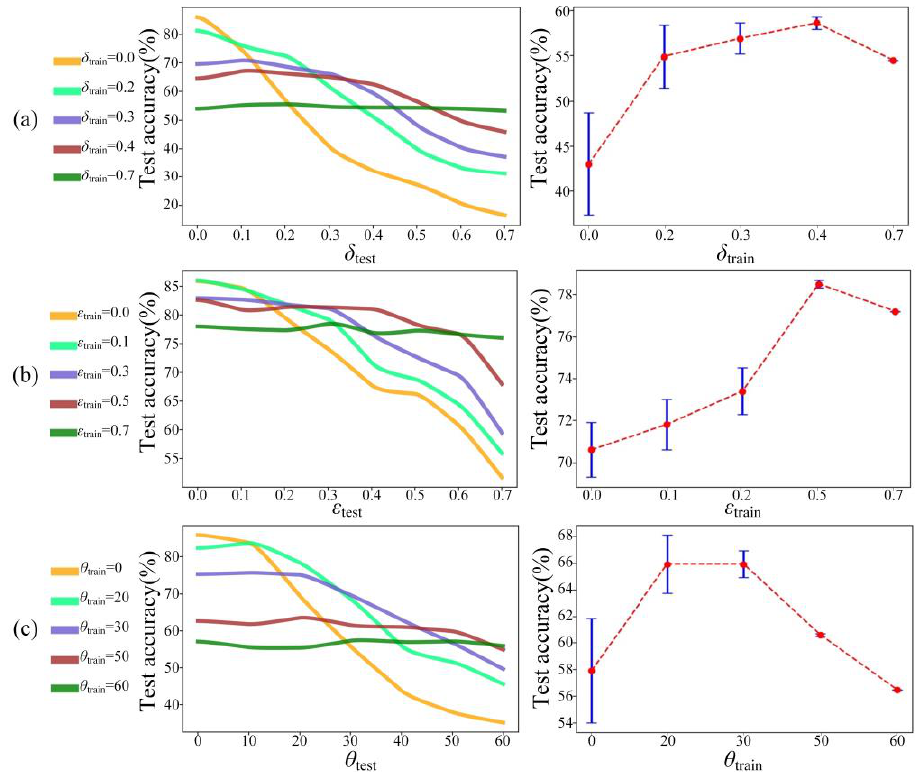
Figure 11. Comparison of the performances using different training strategies. The comparison between the inference accuracies of the mr -MDA resisting target shifting (left) ( a ), resisting target scaling (left) ( b ), and resisting target rotation (left) ( c ). The variance of each curve is in the left picture (right). The value corresponding to the red point in the right subgraphs represents the mean, and the distance from the red point to the upper and lower ends denotes the variance.